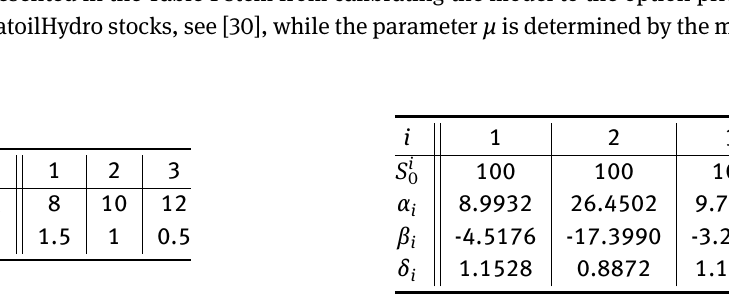
Table 1: Artificial parameters for the log-normal model (left) and parameters from calibrated real market data for the NIG model